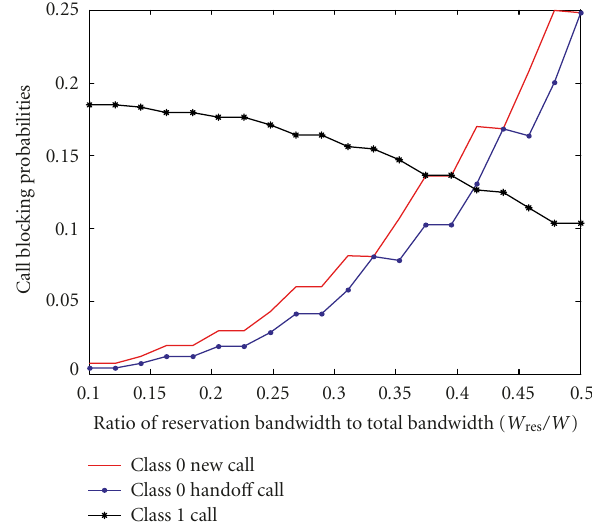
Figure 5: Call blocking probabilities versus reservation bandwidth